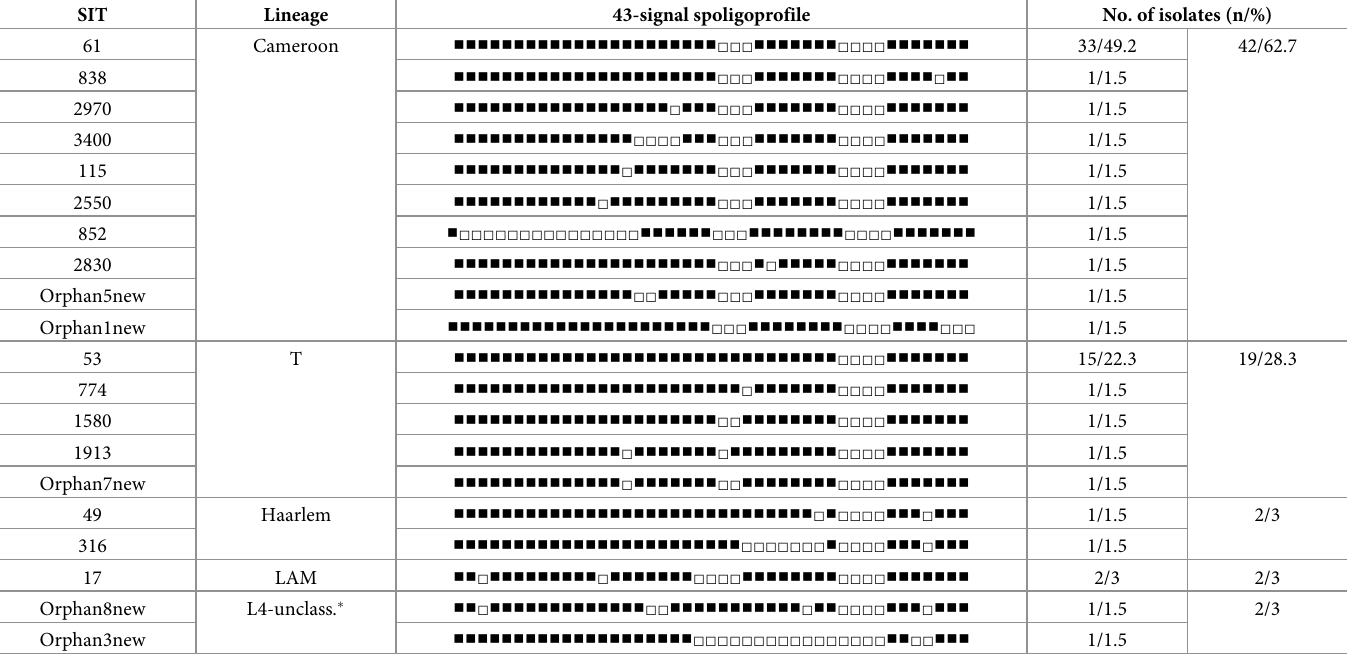
particular the ancestral state of the SIT53 and taking into consideration that M . tuberculosis CRISPR/DR locus is evolving by loss of spacers. Although the picture is simplified it gives an adequate view of the sequence of events behind evolution of the Nigerian spoligotypes, and a local historical evolution of the Cameroon lineage. Two Haarlem strains had different SITs (Table 2) and due to their single deletion event dif- ference, they could not be directly linked to each other. In addition, they differed in other